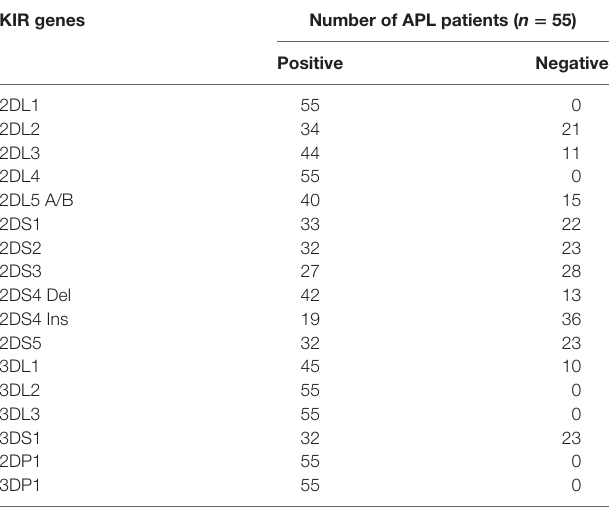
TaBle 2 | Table showing the presence or absence 16 KIR genes screened in APL patients ( n = 55). Kir genes number of aPl patients ( n = 55)